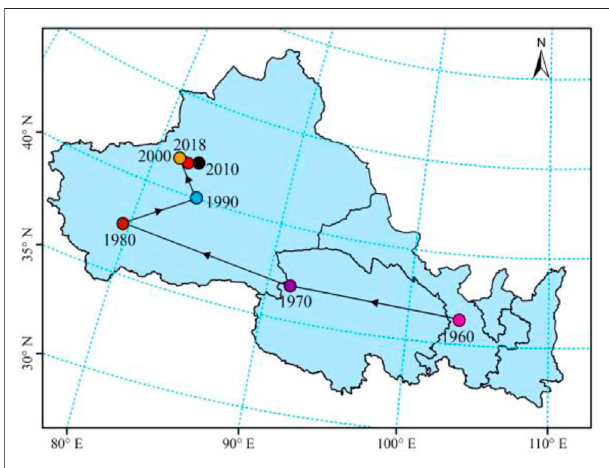
FIGURE 7 | Migration of gravity center of SPI.